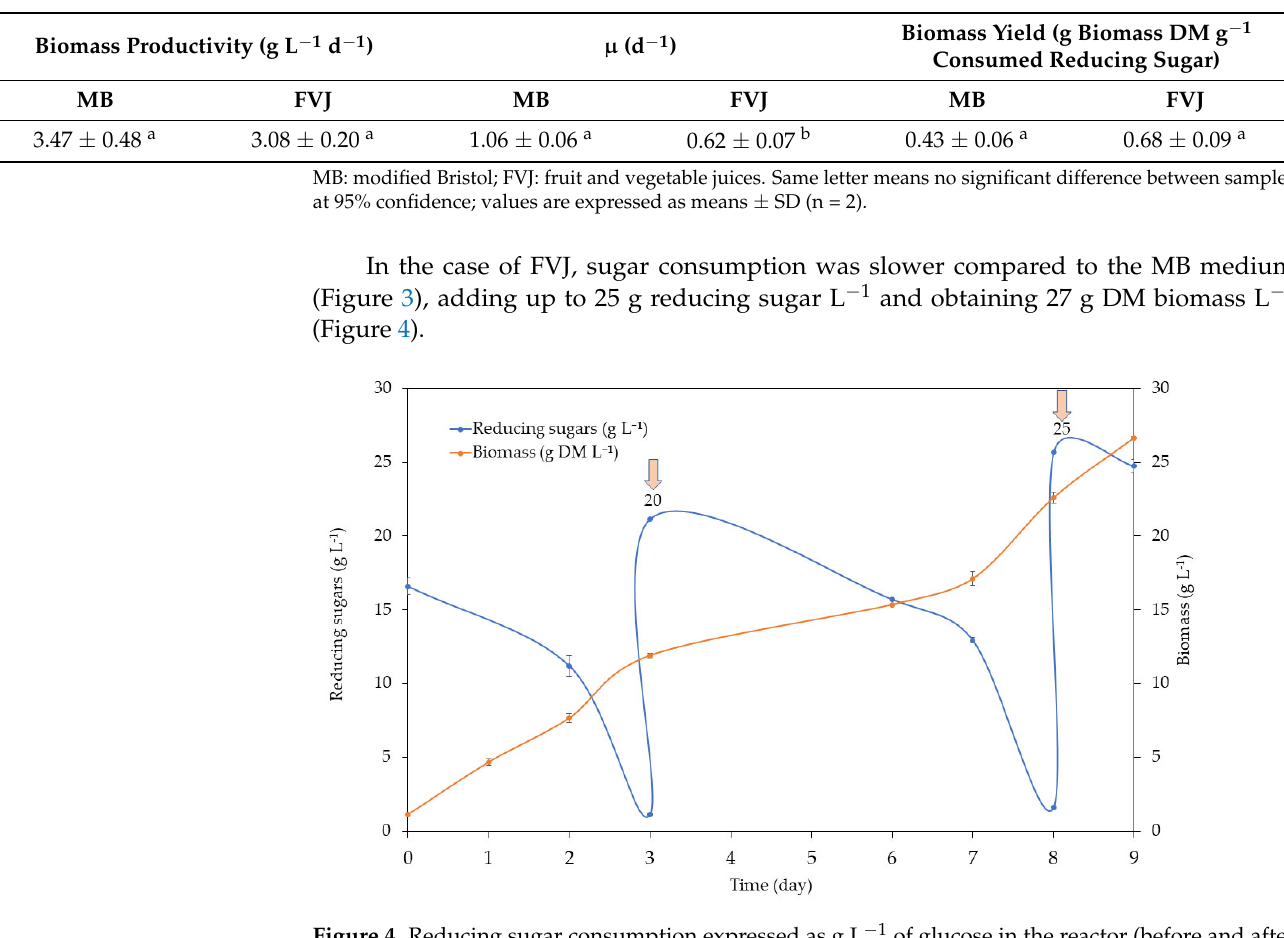
Table 6. Biomass productivity and specific growth rate ( µ ) in Fed-batch reactor trials.